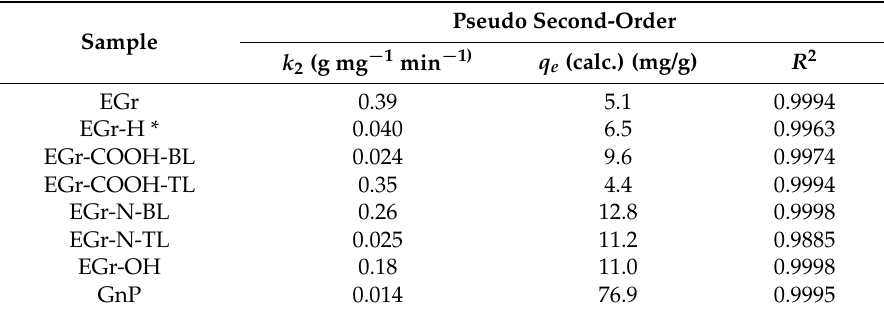
Table 3. Kinetic parameters for bovine serum albumin (BSA) adsorption from phosphate-buffered saline (PBS) on the initial and modified expanded graphite materials (mass loading ~100 mg; initial concentration of BSA 1 mg/mL; liquid phase volume 5 mL) and on the graphene nanoplatelets (GnP) (mass loading ~100 mg; initial concentration of BSA 2 mg/mL; liquid phase volume 10 mL). k 2 is the rate constant of the pseudo-second-order adsorption rate equation; q e is the adsorption capacity at equilibrium; R 2 is regression